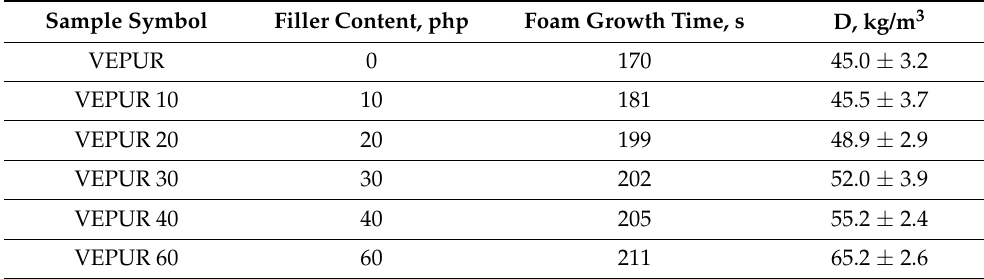
Table 3. Designation of tested foams, their growth time, and apparent